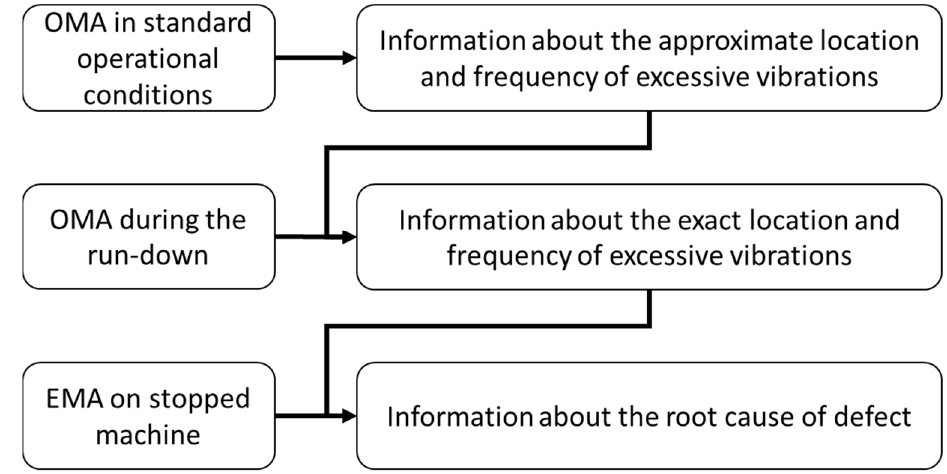
Figure 1. Schematic description of the proposed approach.